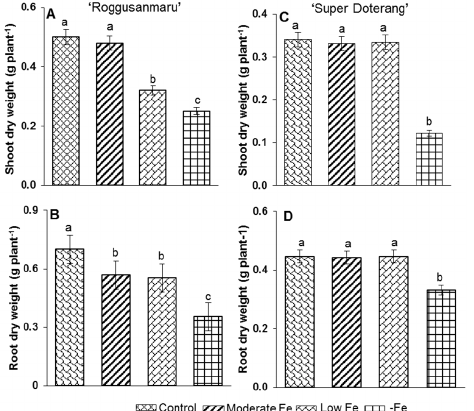
Figure 2. Dry weight in ( A , B ) shoot and roots of “Roggusanmaru” and ( C , D ) “Super Doterang” tomato cultivar. Plants were grown in Fe-sufficient (control); moderate Fe; low Fe; and Fe-deficient (–Fe) Hoagland nutrient medium for 10 days. Values are Mean ˘ SE ( n = 4). Significant